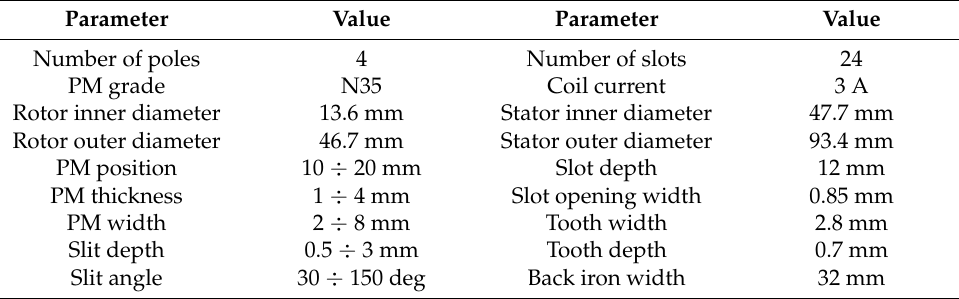
Table 1. Finite element analysis (FEA) design parameters of studied